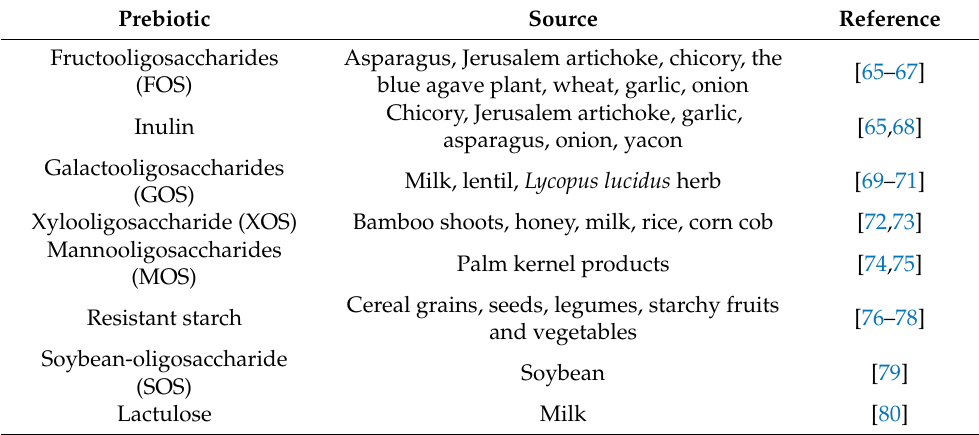
Table 1. Prebiotic